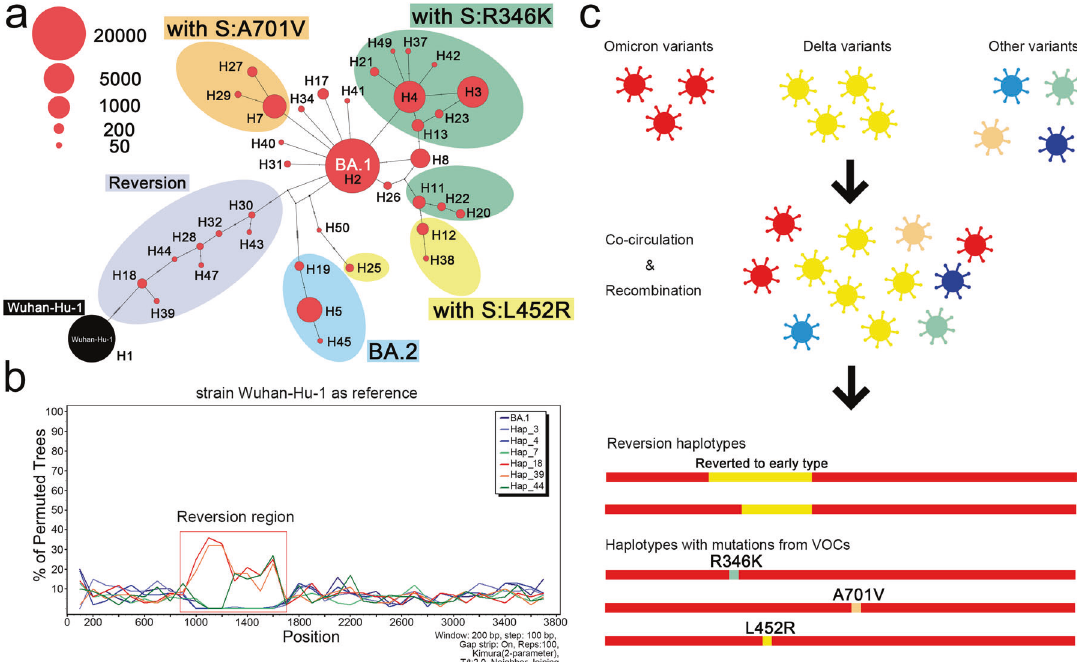
Fig. 3 Phylogenetic network and scanning of the spike gene from representative Omicron subvariant sequences. a Representative Omicron spike protein haplotypes (each consisting of at least 50 sequences) were constructed with PopART using the median-joining method. Nucleotide changes were notated with lines. The spike gene from Wuhan-Hu-1 strain was set as the root. The number of sequences in each haplotype were modi fi ed into different orders of magnitude, and subgroups based on the mutation types were delineated by color. b BootScan analysis of revertant and representative haplotypes of Omicron spike gene. Representative spike Omicron haplotypes (H3, H4, H7) sequences and selected reversion haplotypes (H18, H39, H44) sequences are included. Bootscan map was constructed by Simplot 3.5.1 (https://sray.med.som.jhmi.edu/SCRoftware/SimPlot/) using neighboring-joining method with 100 bootstrap replicates. Wuhan-Hu-1 spike sequences were set as references and reversion region was annotated. c Overview of possible evolution mechanism of reversion haplotypes and haplotypes with mutations from Delta and other